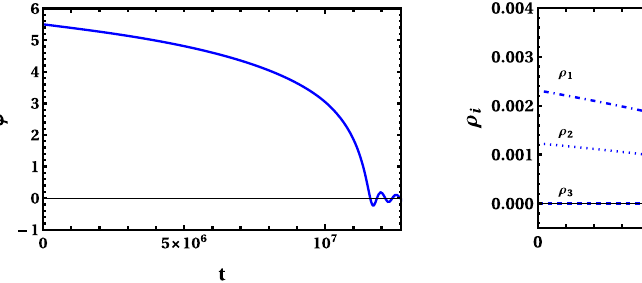
background evolution we have used initial field values ϕ 1 ( t in ) = 5 . 5, ϕ 2 ( t ) = 0 . 002306, ϕ 3 ( t ) = 0 . 001227 and ϕ 4 ( t ) = 0. The pre- in in in scription for finding the initial conditions are discussed in Appendix B and the analytic relations between ϕ and ρ i are given in Appendix C